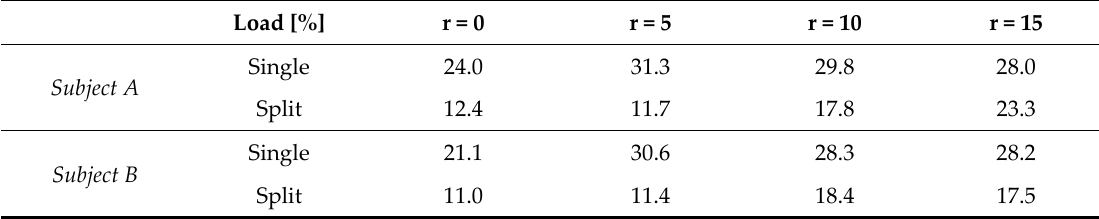
Figure 2. Knee and ankle joint angles of single-belt and split-belt treadmills. Table 1. Angular range of motion of ankle